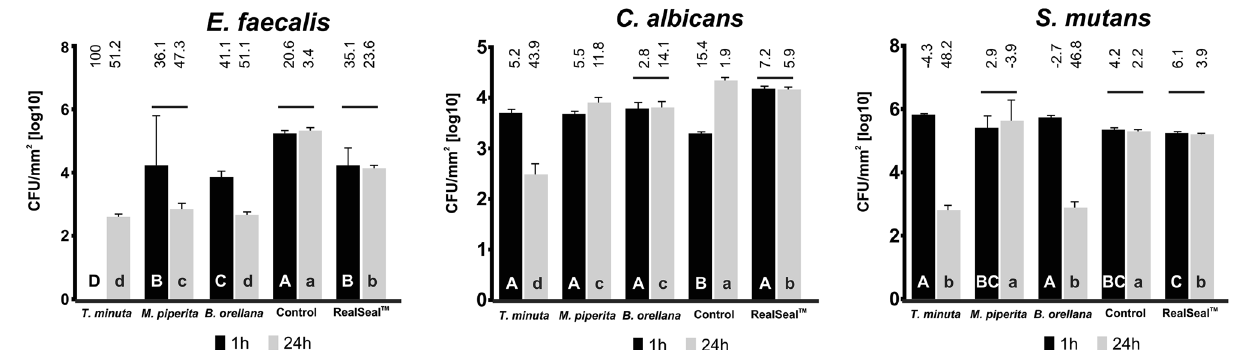
Figure 2. Antimicrobial effects of the test materials. Columns under the same horizontal line indicate no differences between different incubation times (1 h or 24 h). Uppercase letters indicate differences between endodontic sealers at 1 h of incubation time. Lowercase letters indicate differences between endodontic sealers at 24 h of incubation time. Numbers above columns indicate the percentage of log 10 reduction when compared to the microbial growth. Control group = Experimental endodontic sealer with no addition of tincture or